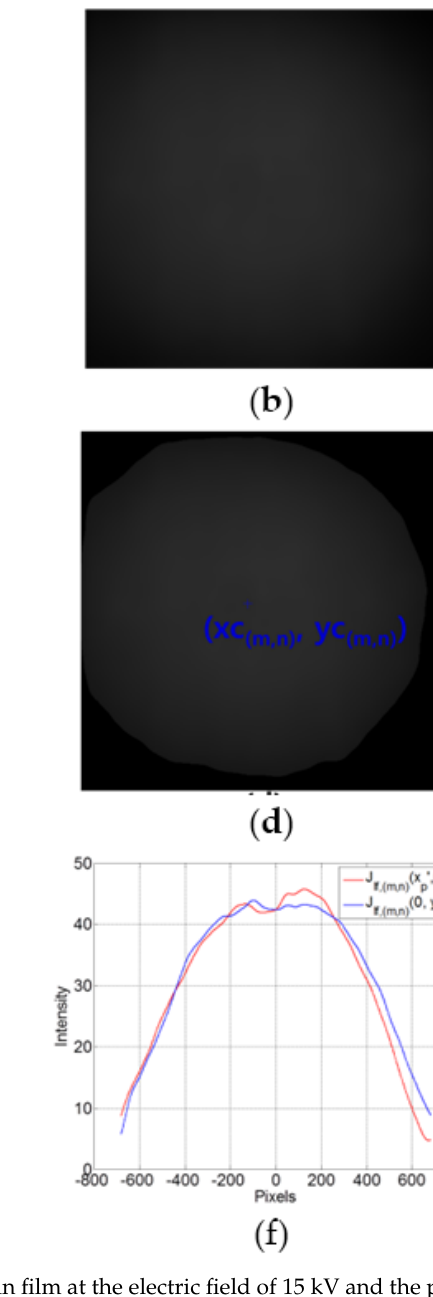
Figure 15. Example of analyzing the coated thin film at the electric field of 15 kV and the pneumatic pressure of 0.0 bar. ( a ) RGB image; ( b ) low-pass filtered gray-scale image. Gray-scale images in which the area that the intensity is less than 80% ( c ) and 50% ( d ) of the maximum intensity was excluded. The center of gravity were marked by ‘ + ’; ( e ) intensity profiles of two diagonal lines that intersect the center position are sampled to see the representative intensity profiles of the coated thin films; ( f ) intensity profiles at two diagonal sample